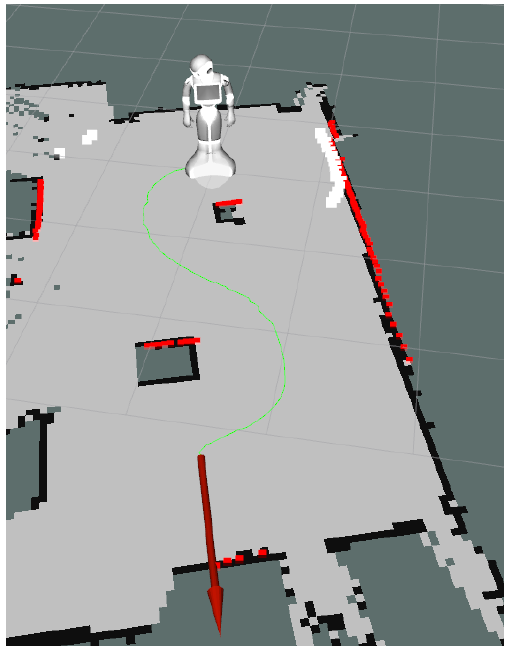
Figure 11. Navigation Area Path with two obstacles. The red dots are the laser scans produced by the Lidar, the white dots are the laser scans produced by the robot, the green path is the A* computed global path, and the red arrow is the goal position.